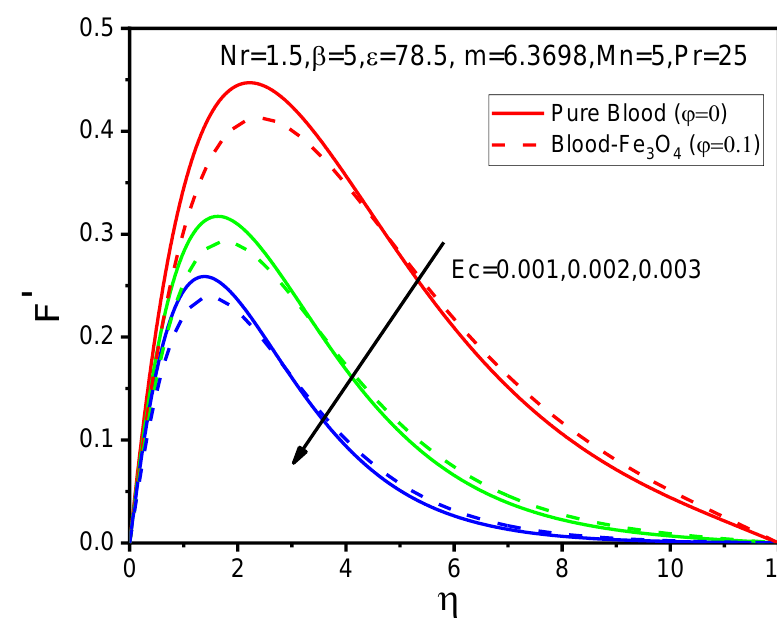
Figure 15. (Case a): Variations of F (cid:48) for Ec = 0.001, 0.002, 0.003 against η